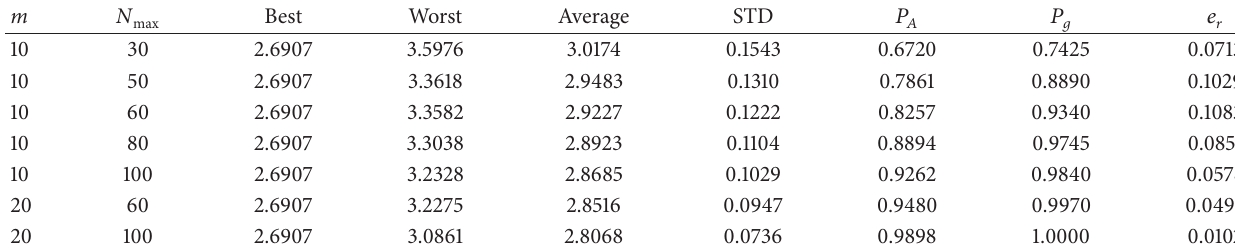
Table 3: Experimental comparison for PSO.